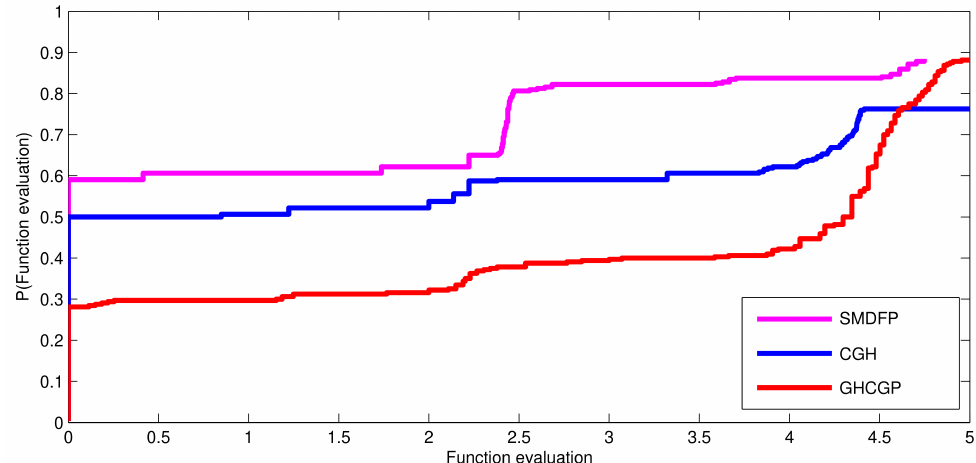
Figure 1. Performance of the SMDFP, CGH [61], and GHCGP [62] methods for the number of iterations.